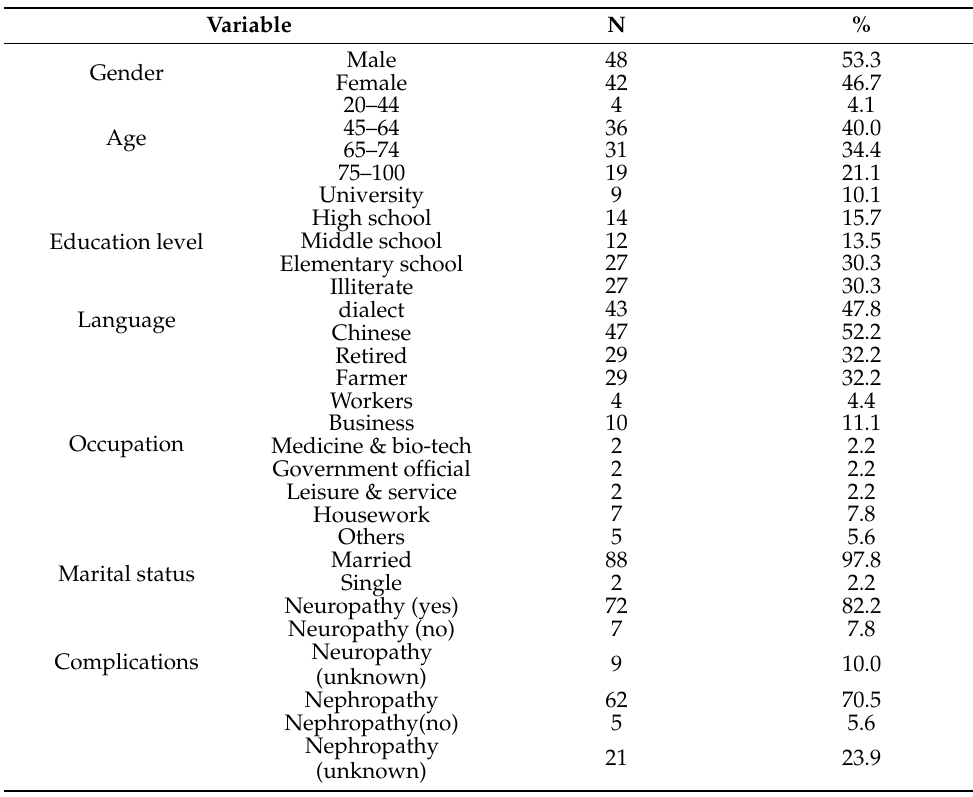
Table 2. Characteristics of diabetic